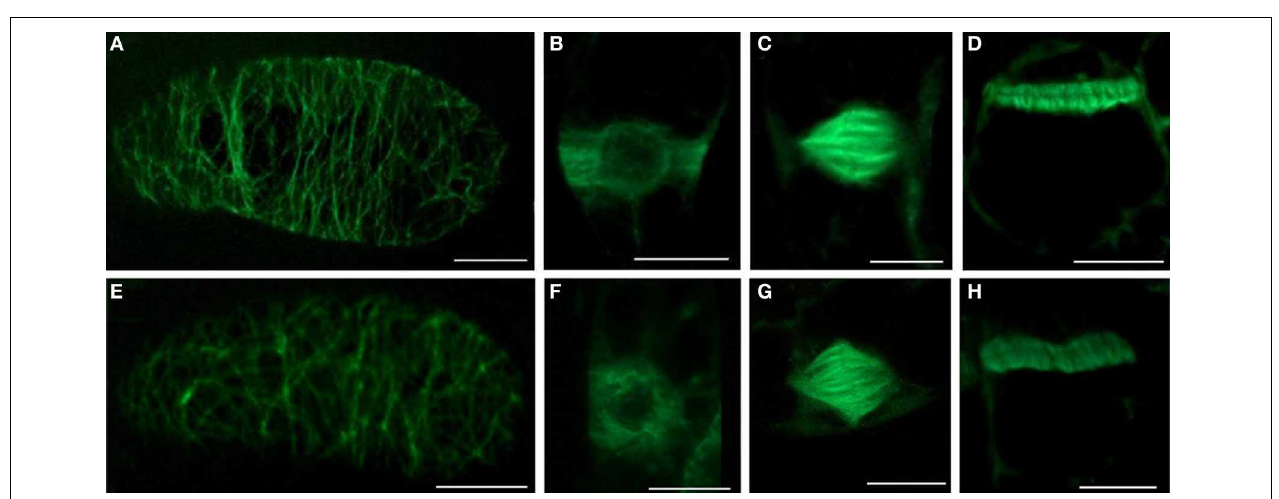
FIGURE 4 | The effects of SNP on the organization of different MTs arrays and on the number of mitotic MTs arrays in BY-2 (GFP-MBD) cells. (A–D) control; (E–H) 5mM SNP treatment during